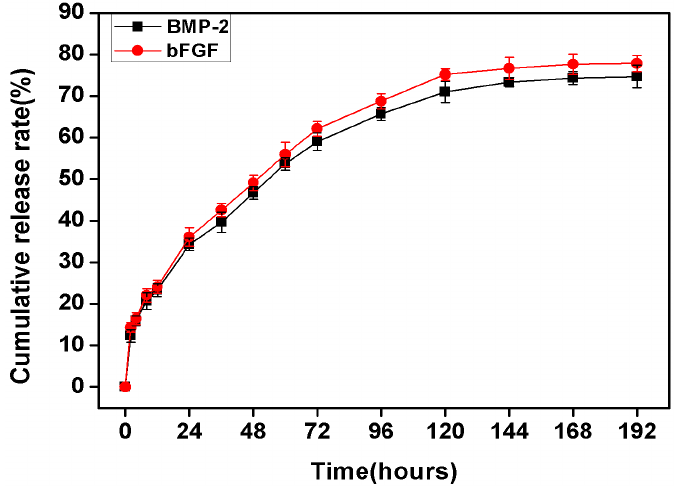
Figure 5. Cumulative release rate of bFGF and BMP-2 per time point from sodium alginate hydrogel and nano-composite scaffolds (PLGA/PCL/nHA) loaded with vascular stents